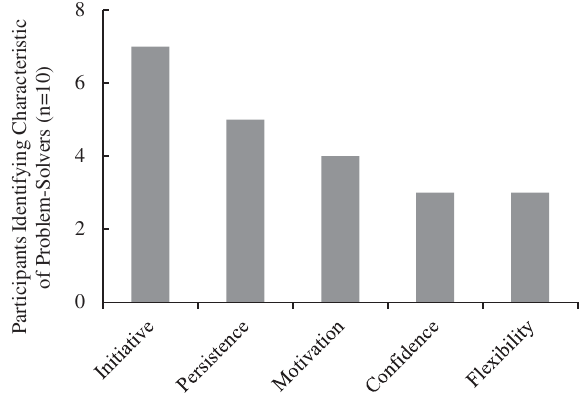
FIG. 7. Characteristics of problem solvers identified by gradu- ate